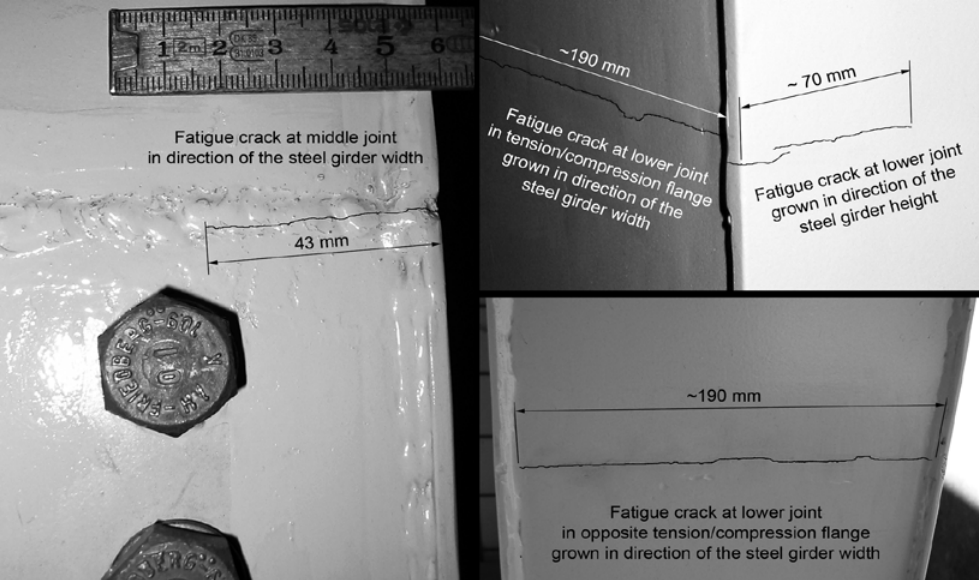
Figure 11. Fatigue cracks in welds after 19 months of